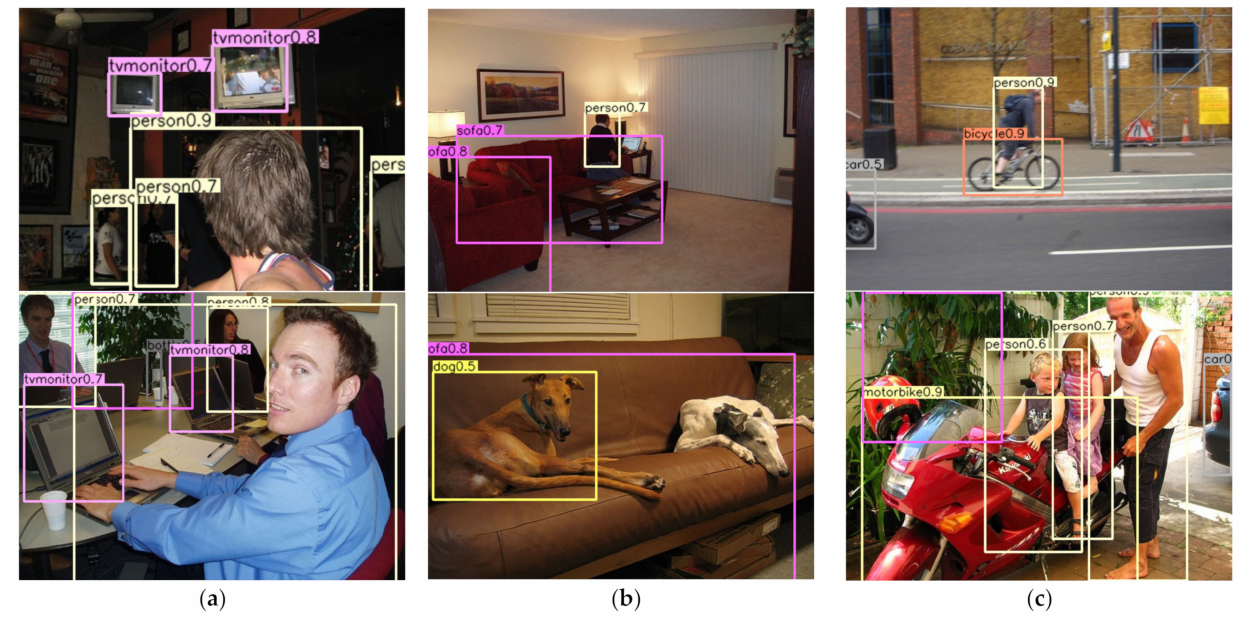
Figure 3. The results of each experiment: ( a ) results of scenario 19 + 1, ( b ) results of scenario 15 + 5, ( c ) results of scenario 10 +